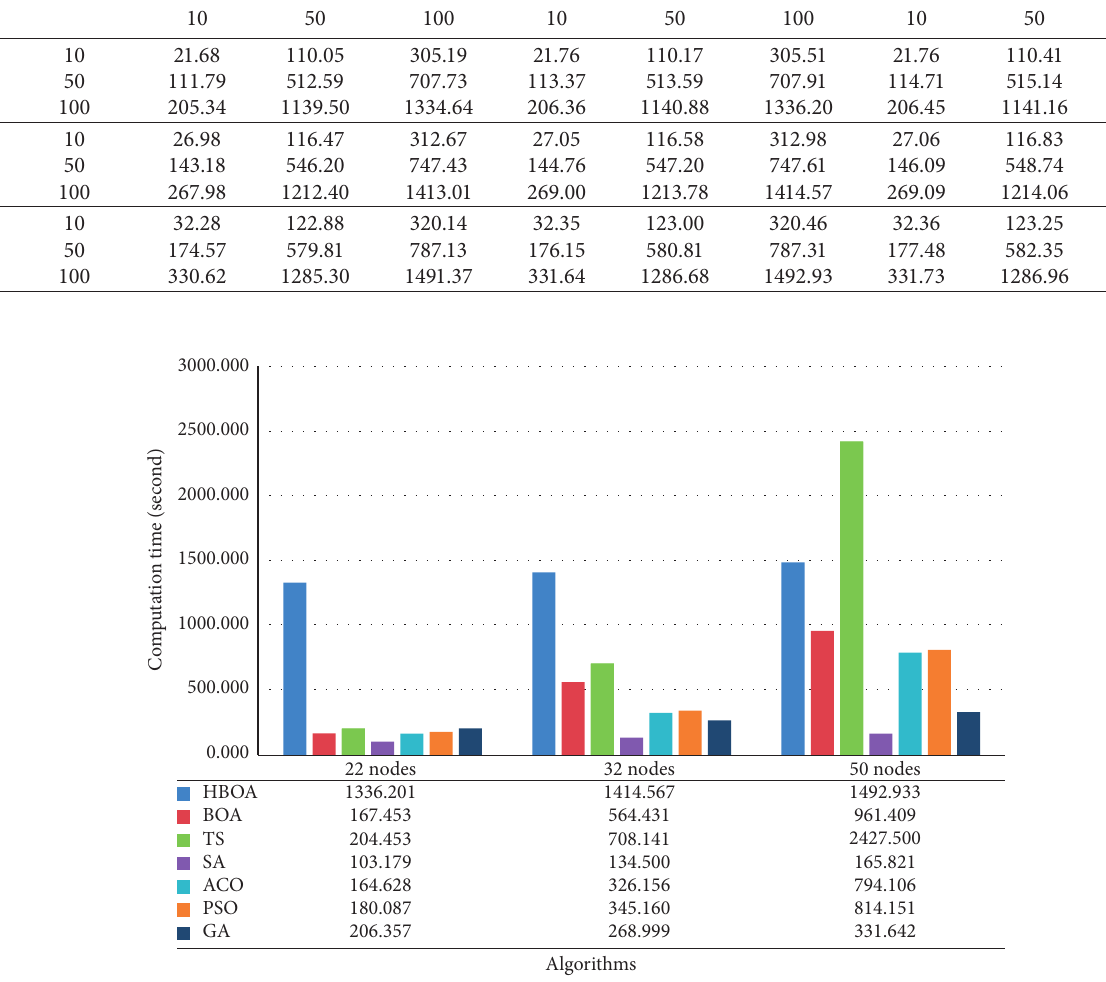
Figure 11: Comparison between the computation time of the proposed algorithm and several other algorithms in the medium speed.